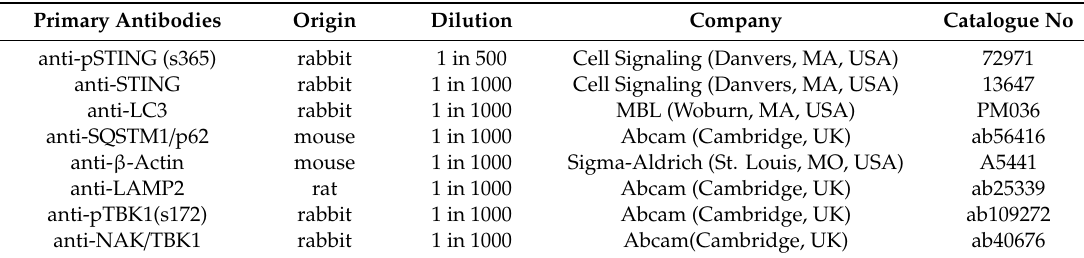
Table 3. Primary antibodies used for Western blot